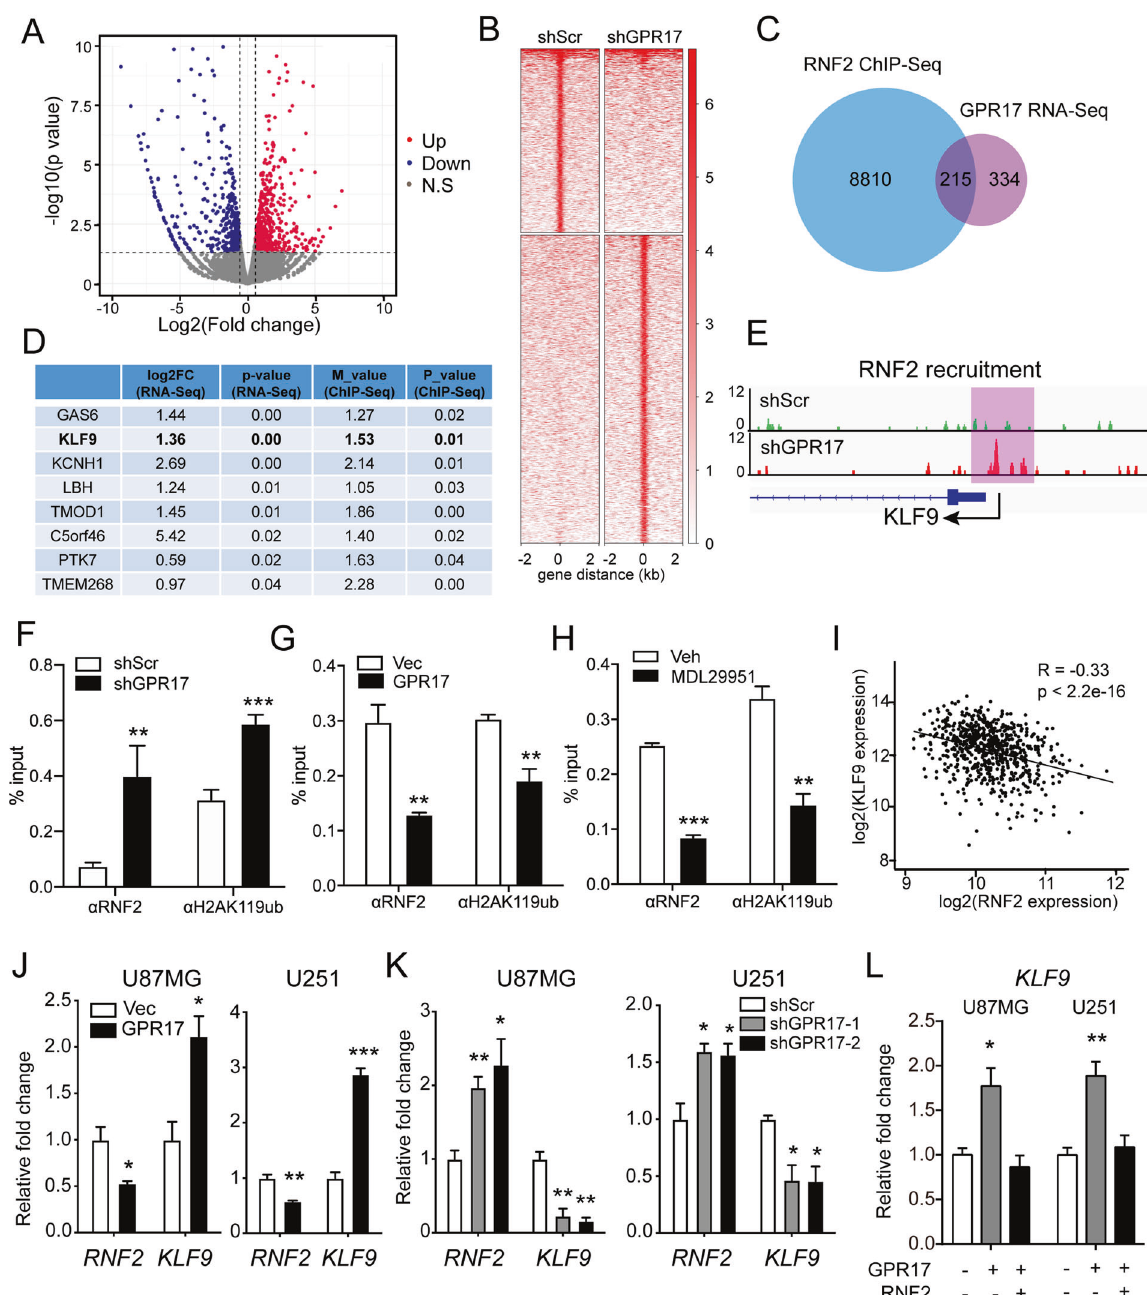
Fig. 5 KLF9 was a downstream target for GPR17 and RNF2 in glioma cells. A Control and U87-GPR17 cells were subjected to RNA-Seq analysis. Volcano plot depicted gene expression changes between control and U87-GPR17 cells. B Control and U87-shGPR17 cells were subjected to RNF2 ChIP-Seq analysis. Density heatmap showed the RNF2 recruitment within ±2 kb around the RNF2 peak center. C Venn diagram showing the overlapped genes in ChIP-Seq and RNA-Seq analyses. D Gene list ranked by RNA-Seq p value with RNF2 binding on promoter-TSS region. E Diagram showing RNF2 enrichment on KLF9 promoter-TSS region. F – H U87-shScr/shGPR17 ( f ), U87-Vec/GPR17 ( G ), or U87MG cells treated with Vehicle/MDL29951 (300 μ M) for 48 h ( H ) were subjected to RNF2 and H2AK119ub ChIP assay; real-time PCR analysis was then performed to assess the relative enrichment of RNF2 and H2AK119ub in promoter-TSS region of KLF9 . I Correlation plot of RNF2 and KLF9 mRNA expression in glioma, grades II – IV, from the TCGA dataset ( n = 667). J , K Control, U87/U251-GPR17, or U87/U251-shGPR17 cells were prepared as in Fig. 2. Cells were harvested for real-time PCR analysis to assess the mRNA levels of RNF2 and KLF9 . L Control or U87/U251- GPR17 cells were transfected with control or RNF2-overexpressing vectors for 48 h, and then subjected to real-time PCR analysis to assess the mRNA levels of KLF9 . For all panels, data represent the means ± SEM from three independent experiments. * p < 0.05, ** p < 0.01, *** p < 0.001, Student ’ s t-